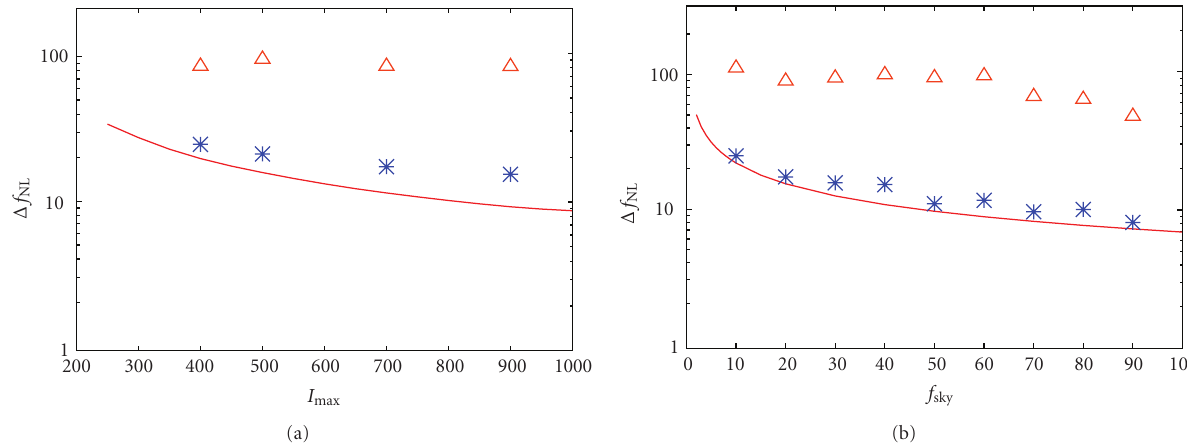
Figure 10: Error bars (obtained from Gaussian simulations) for the pure cubic ( triangles ) and pseudooptimal ( stars ) implementations of the bispectrum estimator, to be compared to the solid red line, representing the Fisher matrix (Rao-Cramer) bound, saturated by the full- optimal statistic described in the text. (a) Error bars as a function of the maximum multipole included in the analysis. (b) Error bars as a function of the fraction of the sky considered in the analysis. This analysis included both temperature and polarization data, from the study by Yadav et al. in